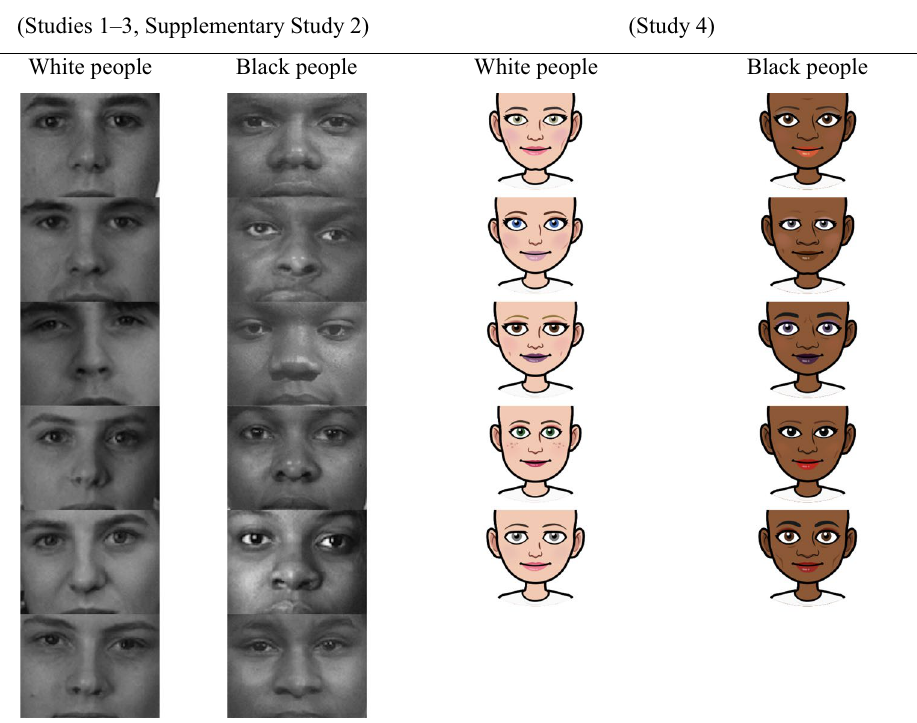
Table 3 Procedure of Studies 1–4